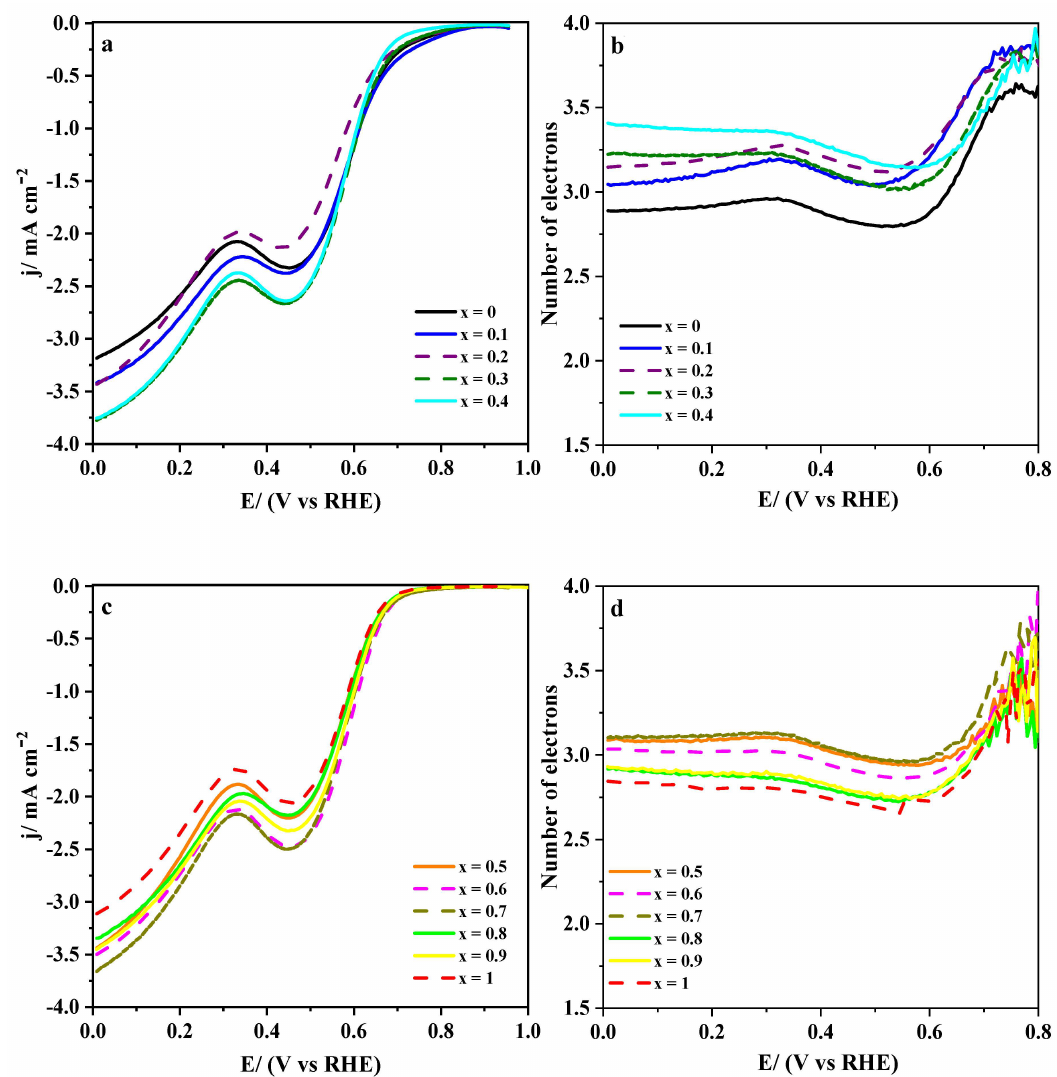
Figure 2. ( a , c ) Linear sweep voltammograms recorded at 1600 rpm for LaMn 1 − x Co x O 3 perovskites in O 2 -saturated 0.1 M KOH solution. Scan rate: 5 mV / s; ( b , d ) Electron transfer numbers calculated from the current measured at the ring using Equation